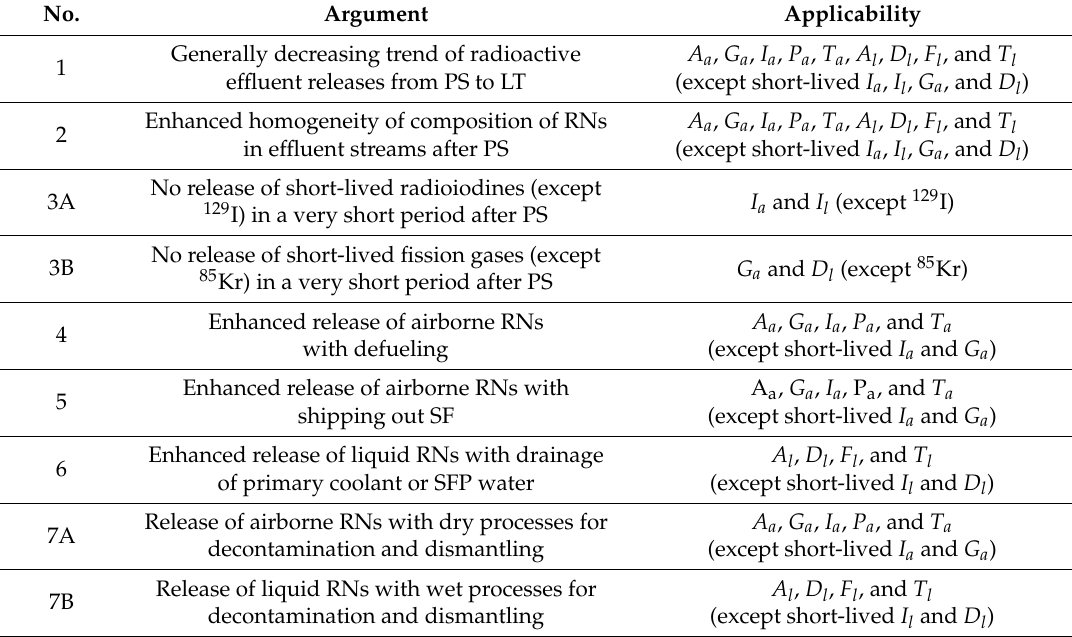
Table 4. Major arguments for characteristics of radioactive e ffl uent releases from decommissioning NPPs derived from source term models proposed in this